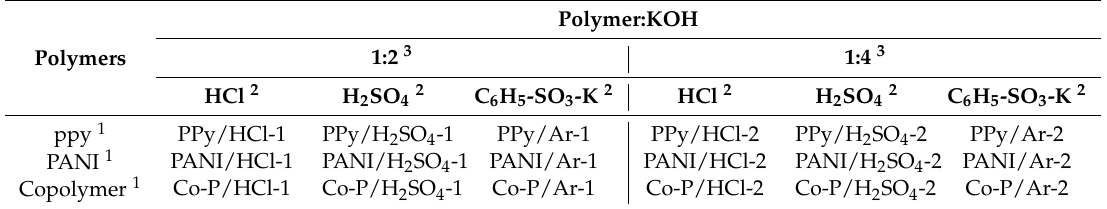
Table 1. List of N-GOs samples prepared and denotation method employed in the manuscript.